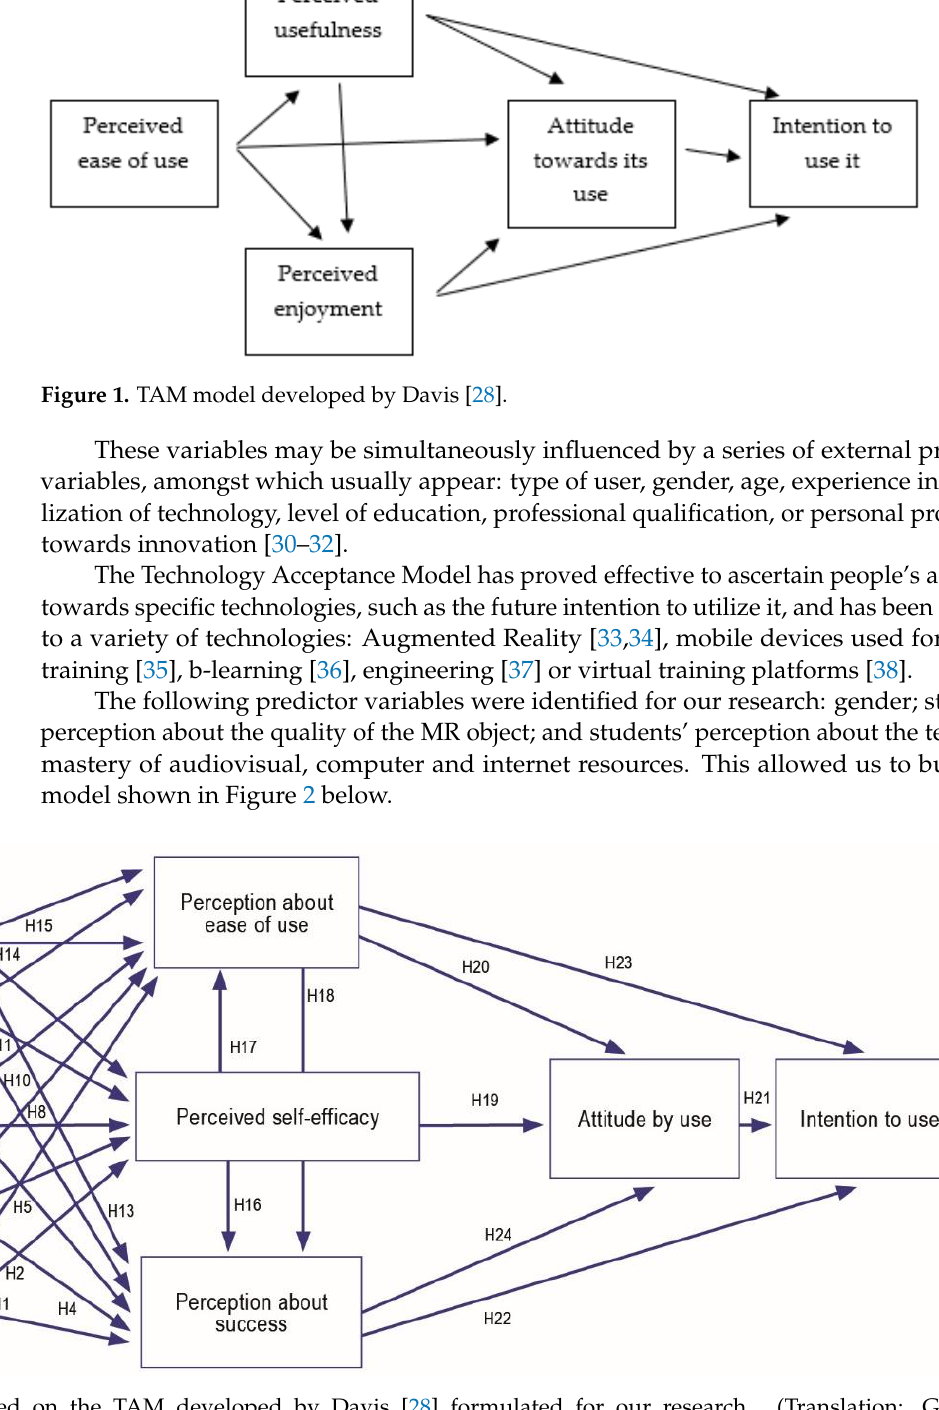
Figure 2. Model based on the TAM developed by Davis [28] formulated for our research. (Translation: Gender//Quality//Internet technical mastery//Audiovisual technical mastery//Computer technical mastery; Perception about ease of use//Perceived self-efficacy//Perception about success; Attitude by use//Intention to use).